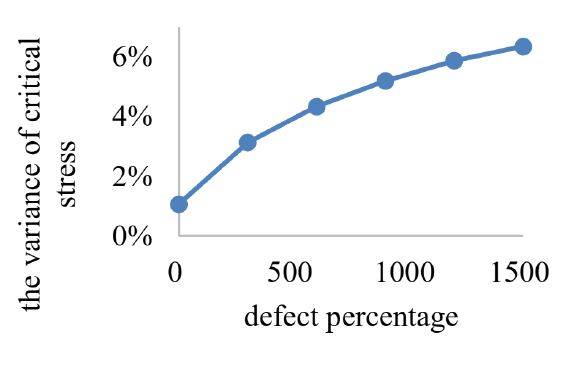
Figure 7: The variances of the critical stress for different percentage defect of zigzag BNNS at